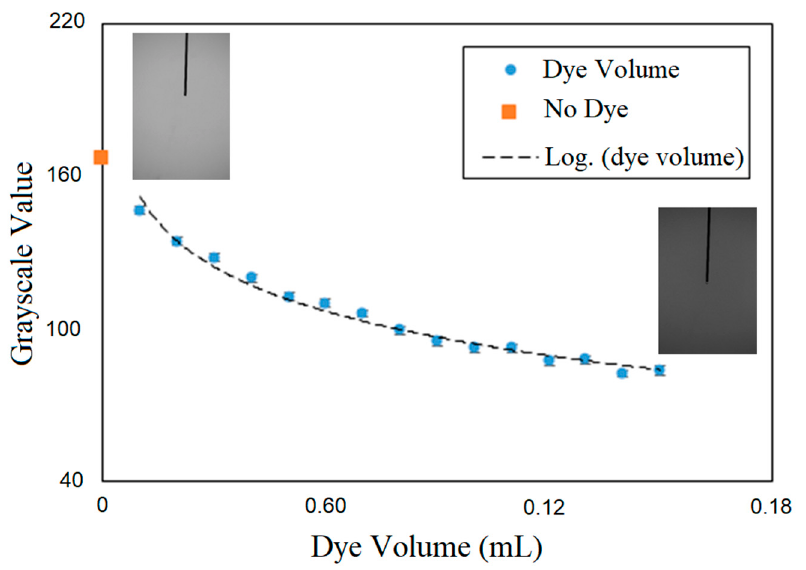
Figure 3. Change of grayscale value with dye injection.